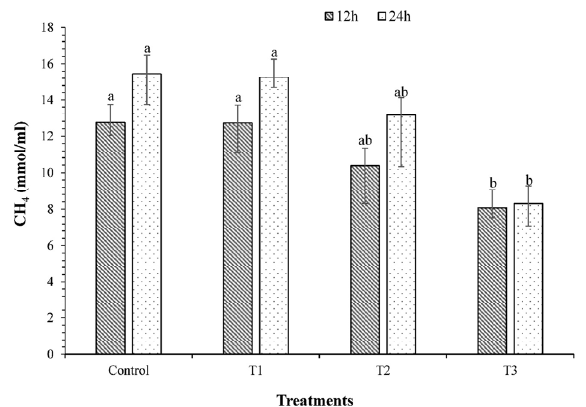
Figure 1. Methane concentration (mmol/mL) from as influenced by the addition of lysozyme. Control: without lysozyme, T1: 2,000 unit lysozyme, T2: 4,000 unit lysozyme, T3: 8,000 unit lysozyme. a,b Treatments with different letters are different at